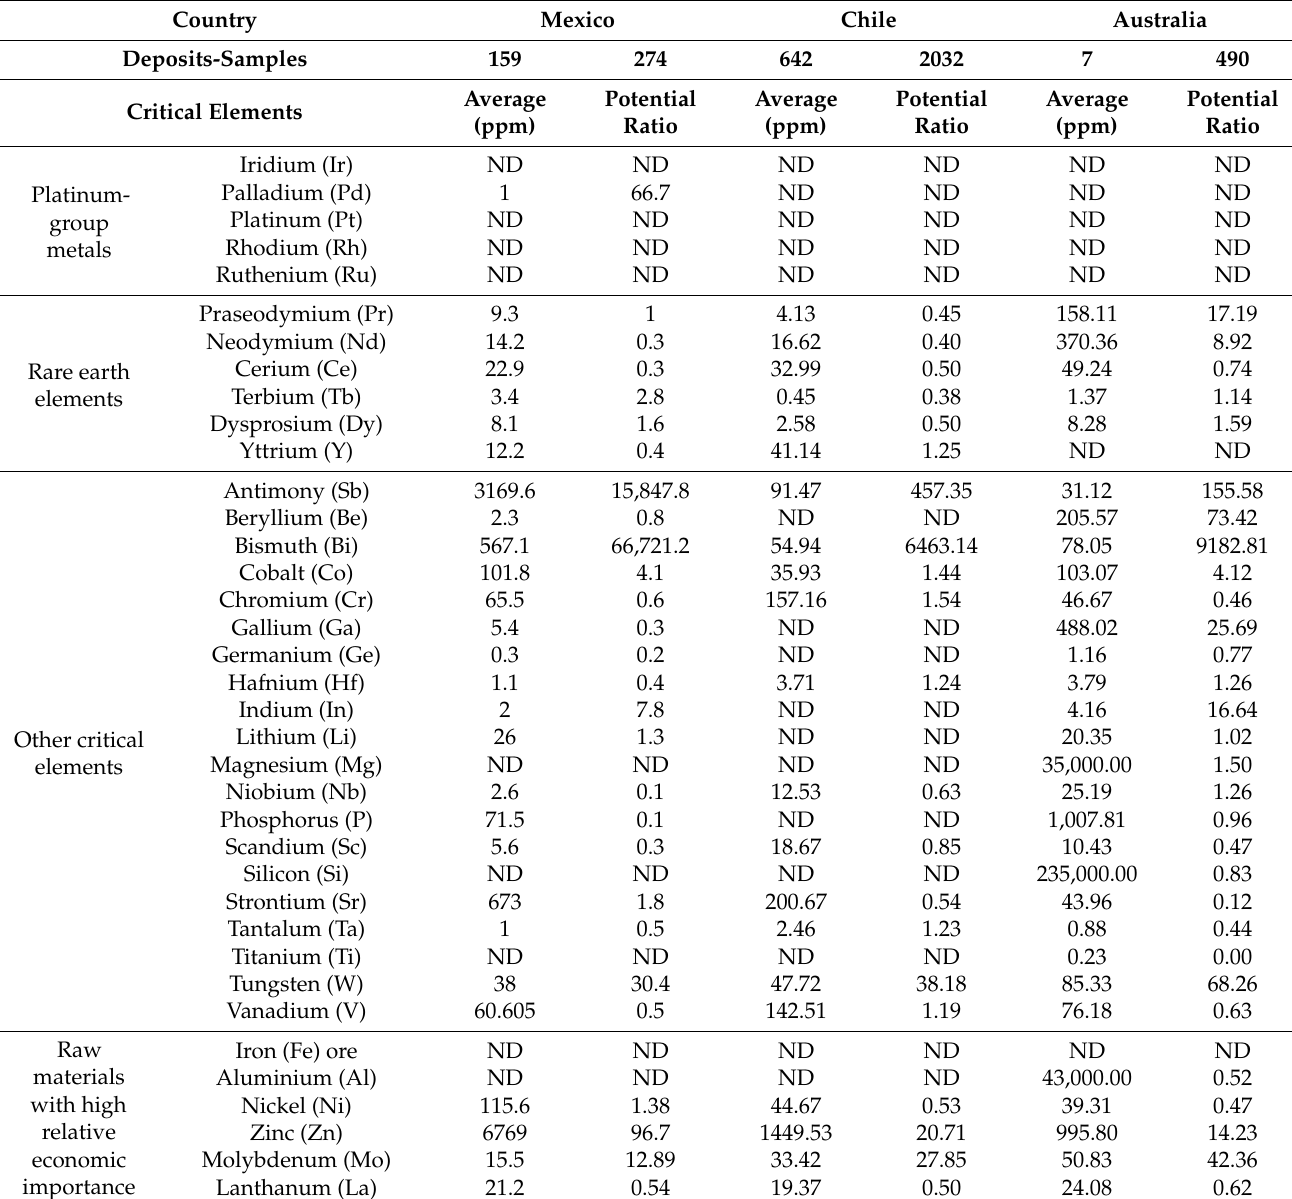
Table 2. Summary of the total number of identified deposits and samples and average concentrations of elements classified as critical and with economic relevance and potential ratio. The potential ratio was calculated by dividing the average value of each element by crustal abundance (Table